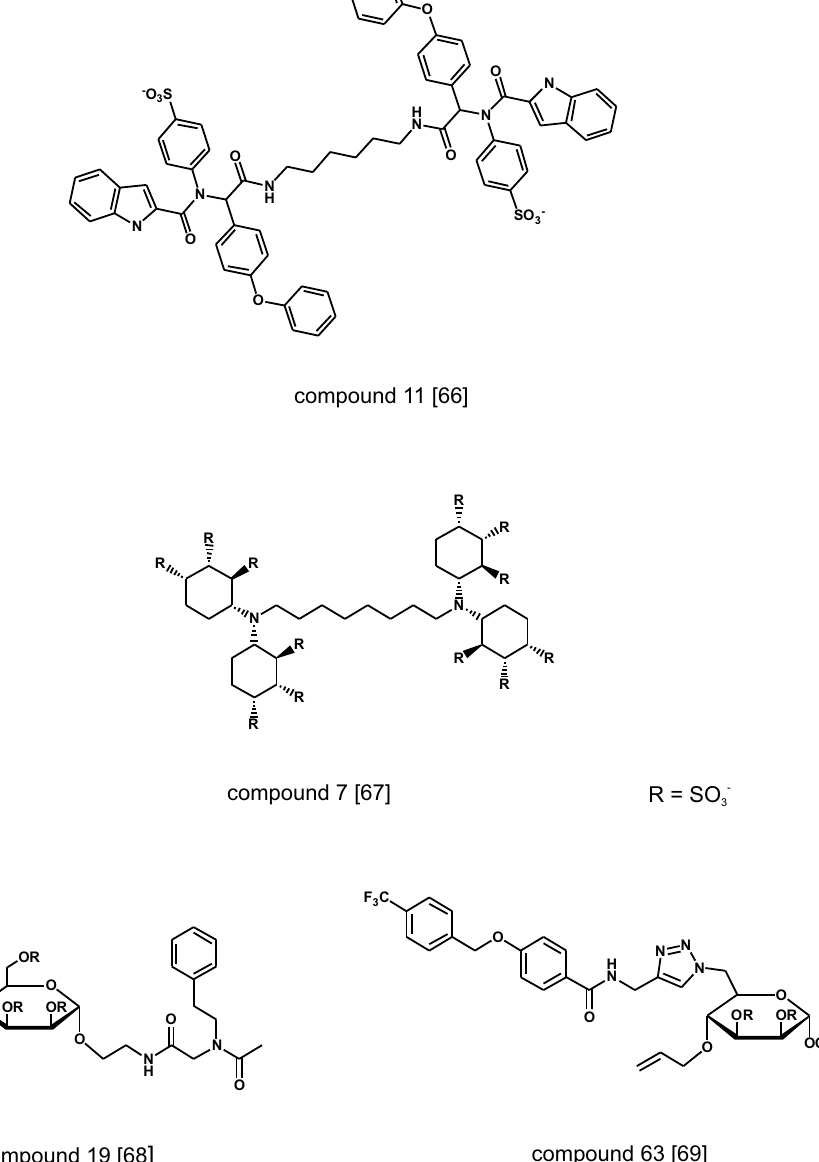
Figure 4. Non-carbohydrate and hybrid small molecules binding to the heparin-binding site of FGF1, FGF2 and VEGF identified by screening of combinatorial chemical libraries. Structures redrawn from refs.